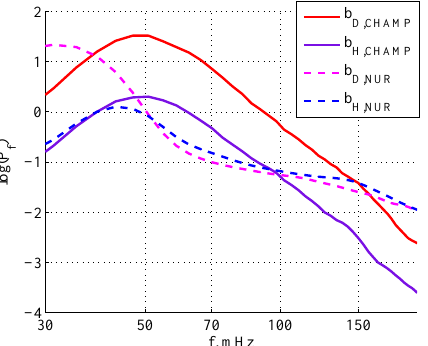
Figure 1. PSD spectra averaged over 6 days in 2007 (253–258) in the 12:00–18:00MLT sector for CHAMP (solid lines) and NUR (dashed lines). Figure 2. High-pass filtered (